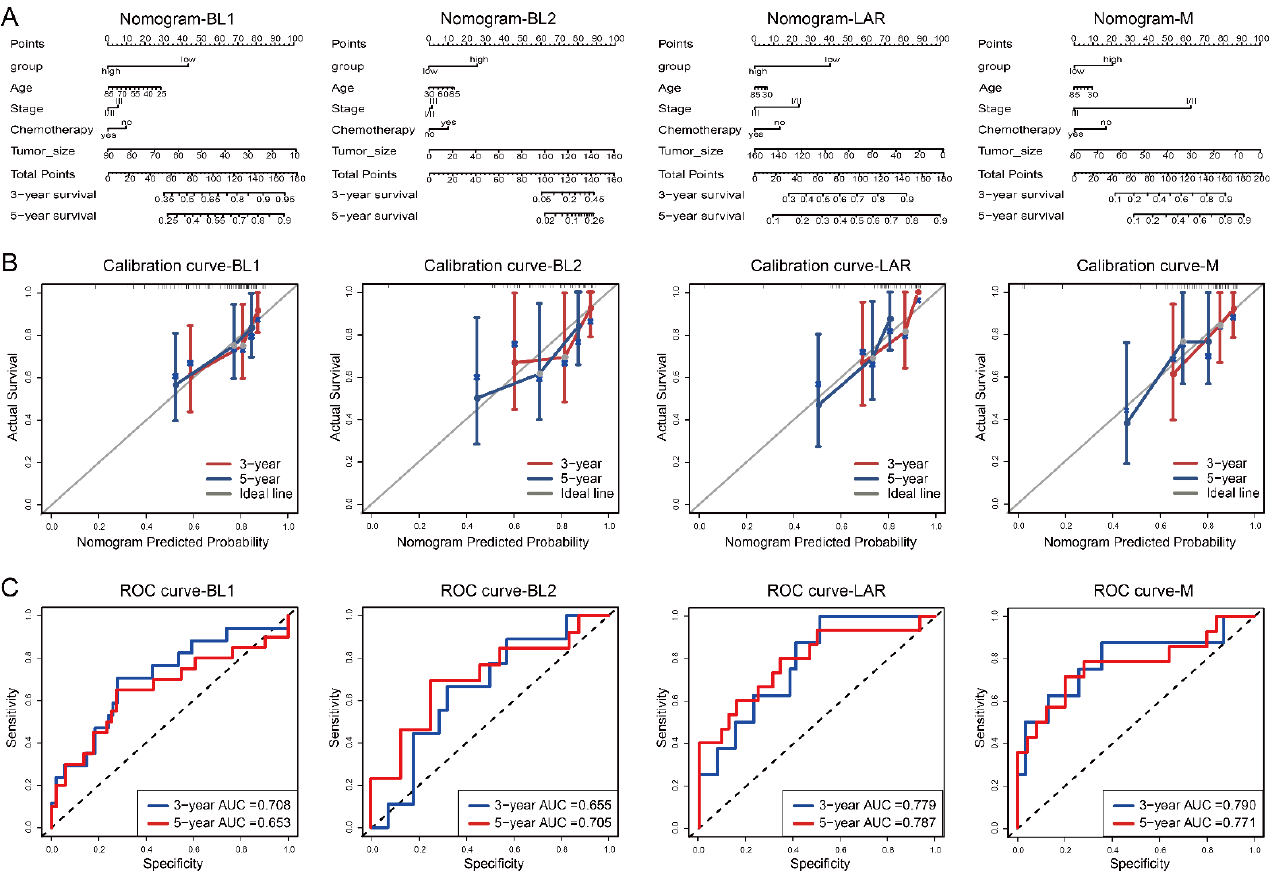
Figure 4. Nomogram, calibration curve and the AUC of the nomogram model, based on the ROC curve used to predict the overall survival time of patients with each subtype in the METABRIC dataset. ( A ) Nomogram, ( B ) calibration curve, ( C ) ROC curve.